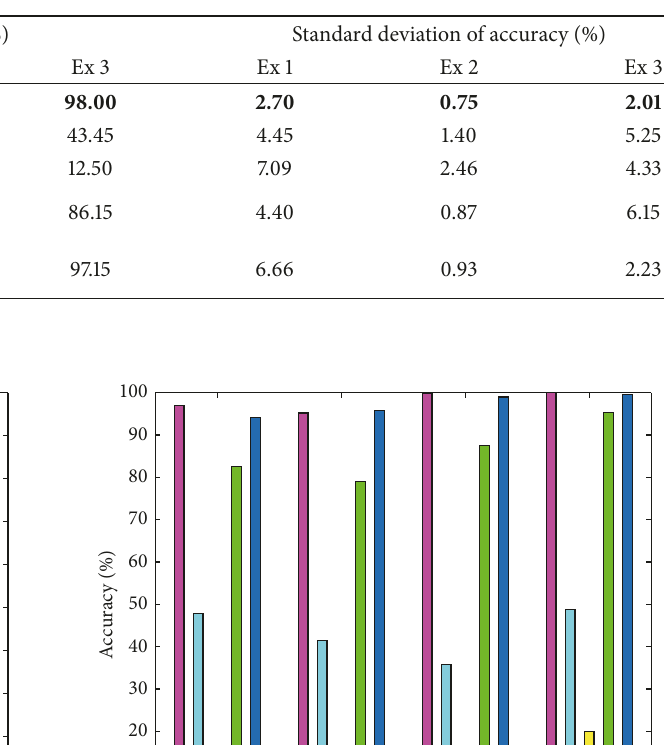
Table 3: The mean and standard deviation of the test results.